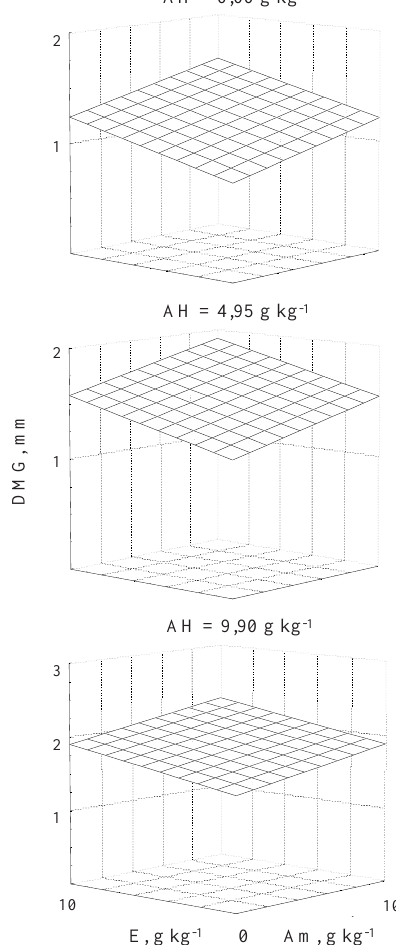
Figura 2. Diâmetro médio geométrico (DMG) dos agregados do horizonte A analisado por via seca, considerando a adição de amido (Am) e ácido esteárico (E), para diferentes doses de ácido húmico